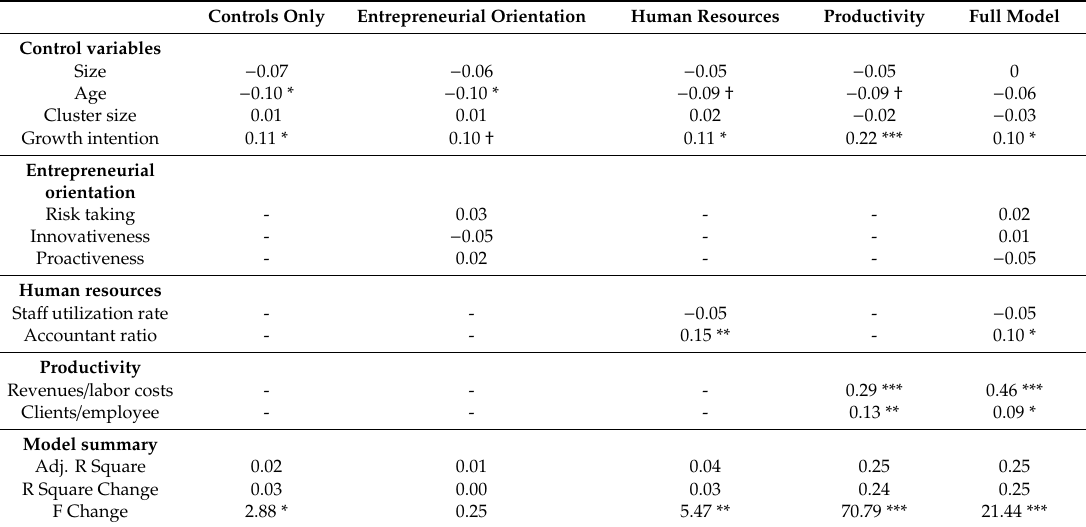
Table 3. Prediction of employment growth from 2011 to 2015 (n =